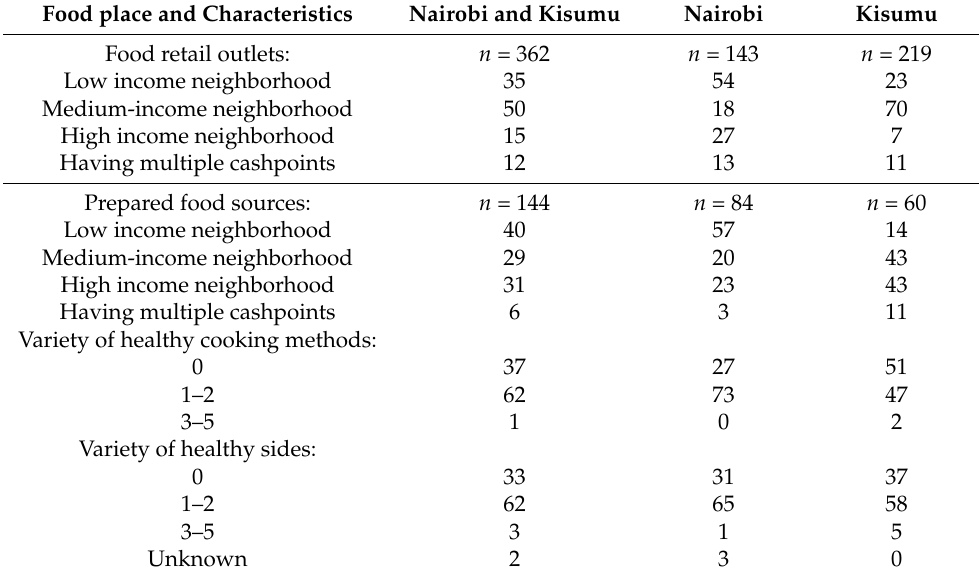
Table 3. Characteristics of food places near schools and neighborhoods 1 (%).